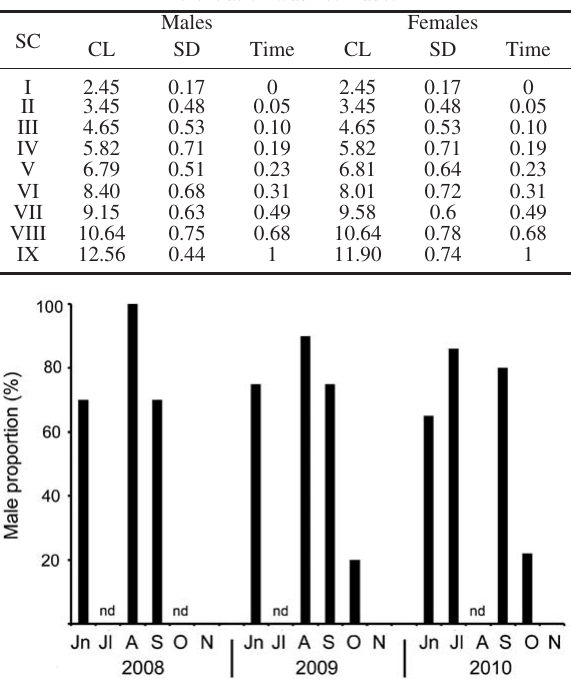
Fig. 6. – Proportion of males that reached gonadal maturity in field samples of young of the year (males) of Munida gregaria in San Jorge Gulf. Fig. 7. – moult stages and sexual maturity proportions for males (a) and females (b) of young of the year of Munida gregaria in labora- tory experiments. Pre, premoult; I, intermoult; Po, postmoult; Mat, maturity.